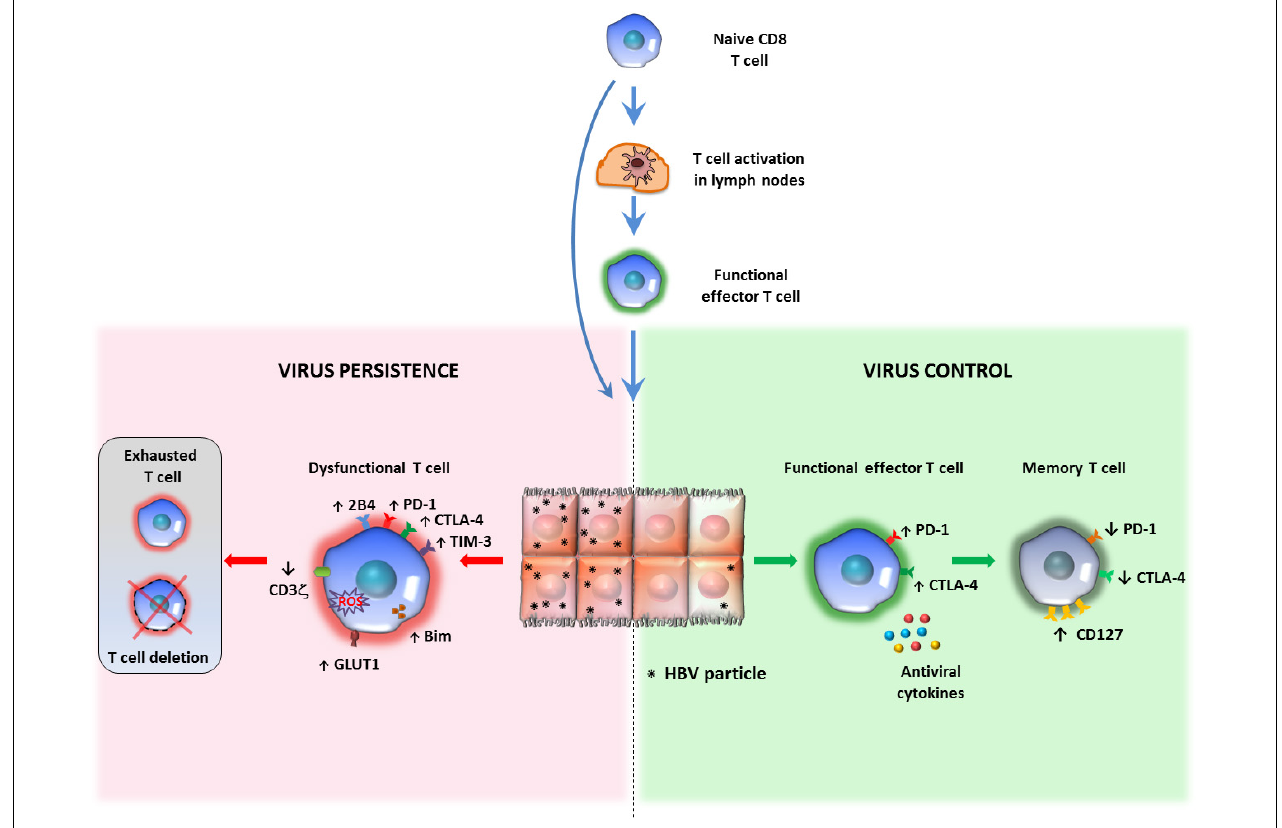
FIGURE 1 | Relationship between antigen persistence and anti-viral T cell responses in the liver. Priming of naïve CD8 T cells can occur in lymph nodes (LNs) or within the liver. In the lymph nodes naïve CD8 T cells differentiate into functional effectors; after migration to the liver, if the majority of hepatocytes are infected and express high antigen levels, virus-specific CD8 T cells undergo functional impairment or physical deletion. Some specific features of exhausted HBV-specific CD8 T cells are the over-expression of multiple inhibitory receptors and pro-apoptotic molecules, CD3 ζ chain down-regulation and various metabolic alterations ( left panel ). If only a minor proportion of liver cells express limited amounts of viral antigens, virus specific CD8 cells can maintain efficient anti-viral activity and can promote virus control and antigen clearance ( right panel ). This model of T cell activation derives form studies performed in mouse models of HBV infection, but no definitive evidence is available in human infection to confirm that induction of functionally efficient effector CD8 T cells is driven by the amount of antigen (number of infected hepatocytes and amount of antigen expressed by individual liver cells) and that decline of antigen can allow restoration of functionally efficient HBV-specific CD8 T cell